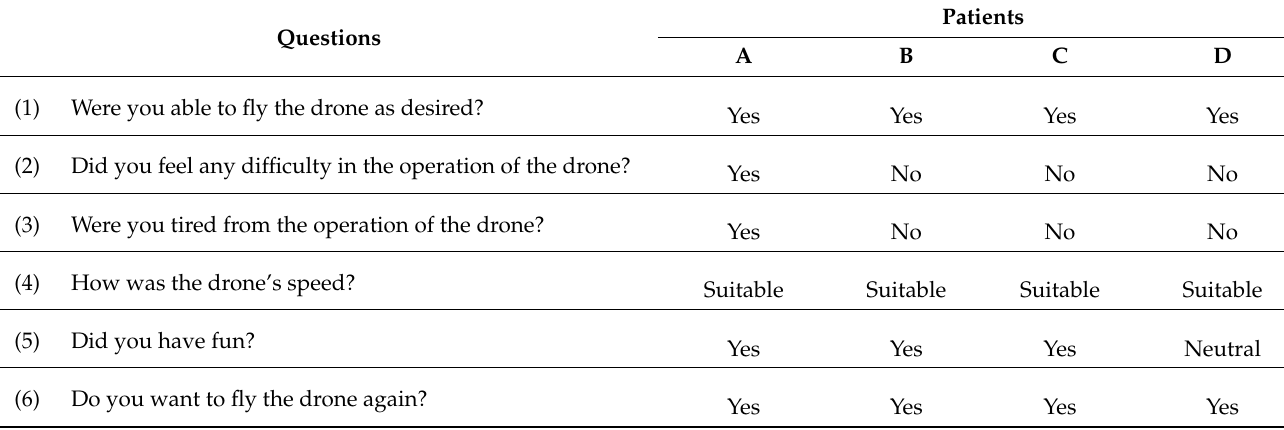
Table 2. Questionnaire results in the preliminary indoor experiment.